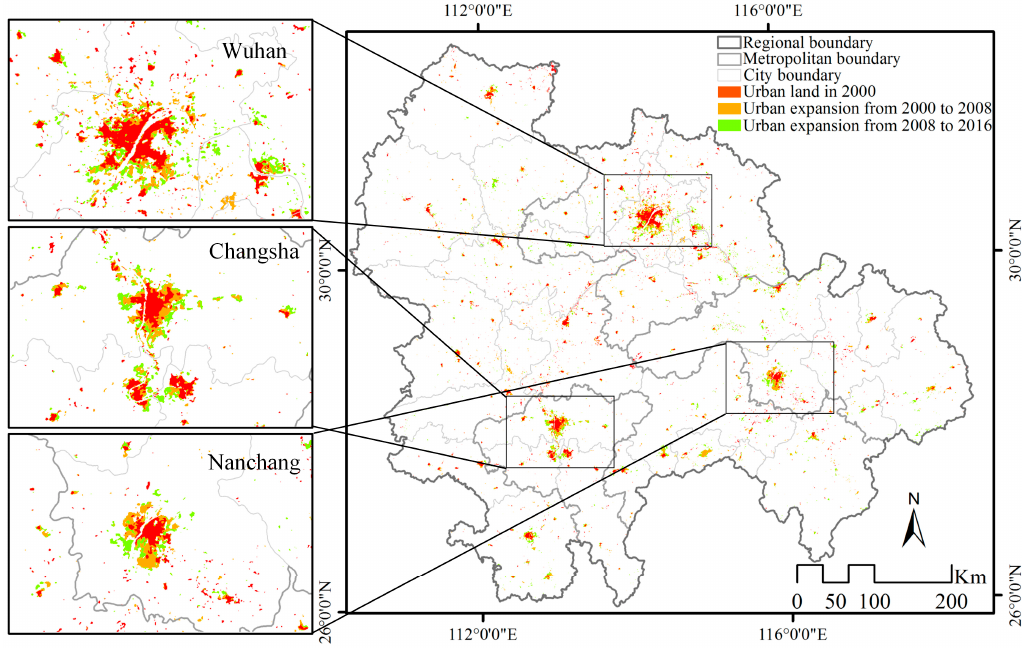
Figure 4. The dynamics of urban expansion in MYRB urban agglomeration from 2000 to 2016. Remote Sens. 2017 , 9 , 1086